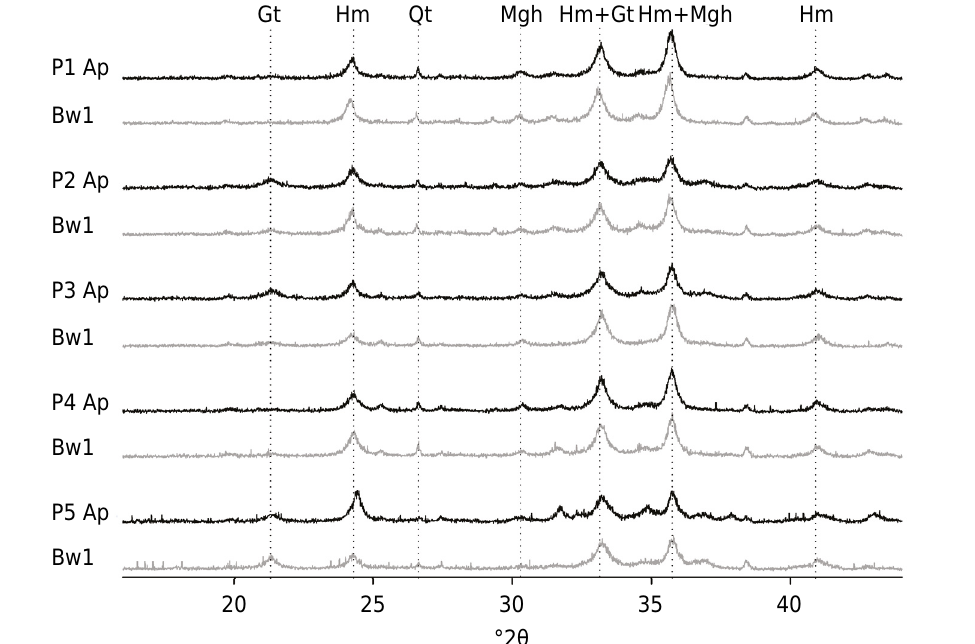
Figure 2. X ray diffractograms of powder samples of the iron oxide concentration, showing the variation in the position of the reflections of goethite (Gt), hematite (Hm), quartz (Qt), and maghemite (Mgh) in the Ap and Bw1 horizons of the five studied profiles. P1: Haplic Ferralsol (Dystric, Clayic); P2: Haplic Ferralsol (Dystric, Clayic); P3: Rhodic Eutric Nitisol (Ochric); P4: Rhodic Ferralsol (Dystric, Clayic); P5: Rhodic Ferralsol (Eutric, Clayic).